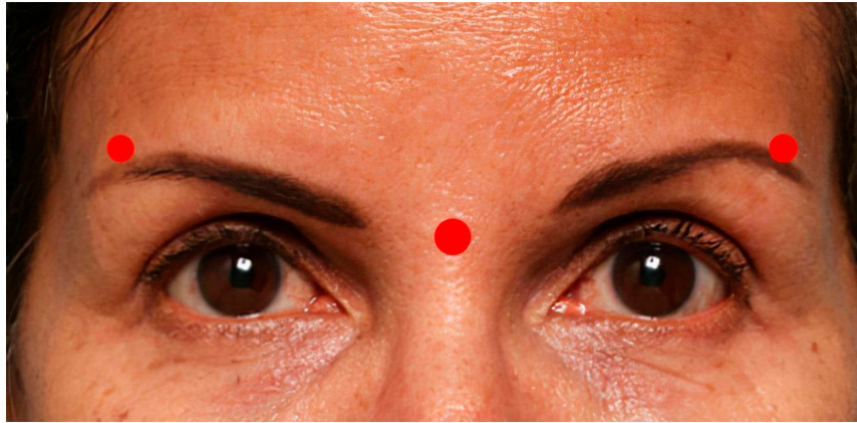
Figure 6. The red dots approximate the placement of botulinum toxin injections [49].